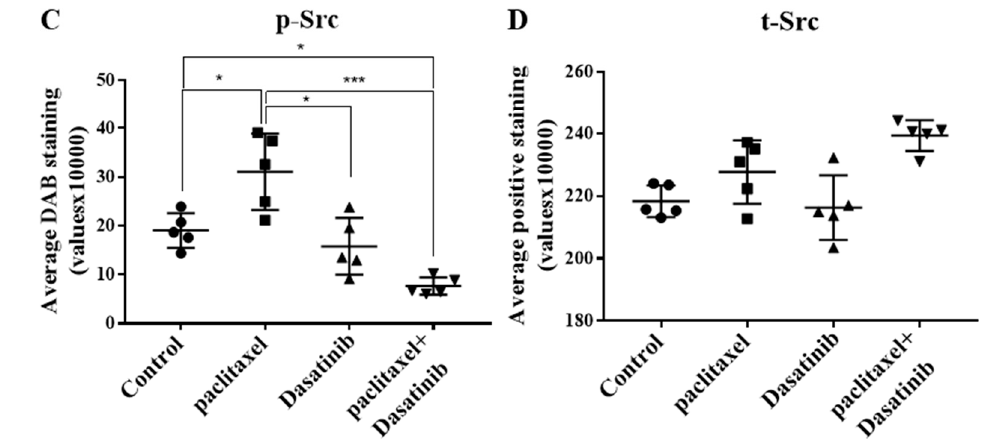
Figure 5. Combination of paclitaxel and Dasatinib treatment regimen in mice reduces tumour burden compared to control group but not to paclitaxel treated group and inhibits the paclitaxel-induced p-Src expression in tumours. ( A ) Tumour burden represented as collective tumour weights, 30 days post transplantation of cells and 12 days post treatment. ( B ) Representative images of p- or t-Src staining in HEY cell derived xenografts. Magnification 200 × scale bar = 200 µ M. Quantification of ( C ) p-Src and ( D ) t-Src, DAB staining was performed using Fiji software. Results are displayed as average DAB staining of the same samples ( × 10,000) ± SD. Significance is indicated by * p < 0.05, ** p < 0.01, *** p < 0.001, **** p < 0.0001.